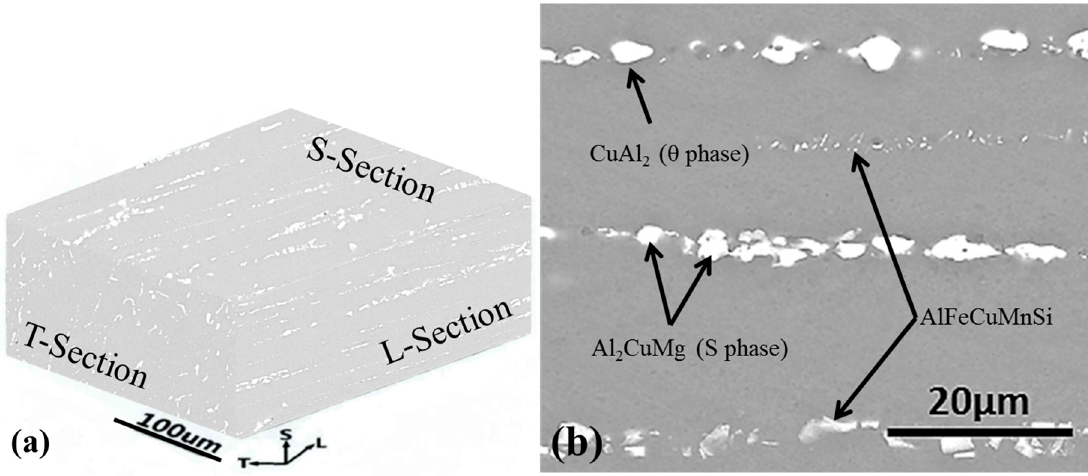
Figure 2. SEM morphologies of a typical microstructure of 2A02 Al alloy. ( a ) three-dimensional whole stereogram microstructure with S-section, T-section, and L-section; ( b ) detailed surface morphology of 2A02 Al alloy on S-Section microstructure.